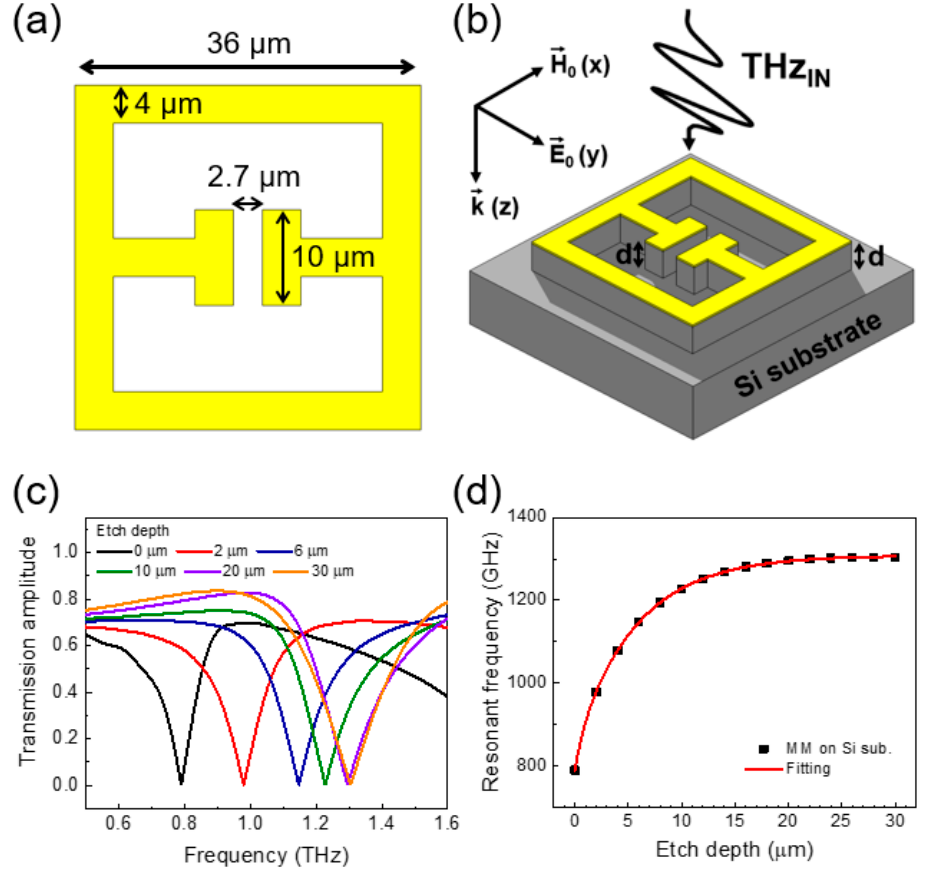
Figure 1. ( a ) Split-ring resonator (SRR) pattern used in the simulations. ( b ) Schematic of THz transmission simulation geometry used. Etch depth is labelled d , with linear THz polarization assumed in the y–z plane as shown. ( c ) THz transmission of the metamaterial for various etch depths around the fundamental resonance. ( d ) The resonant frequency of the metamaterial plotted as a function of etch depth d .